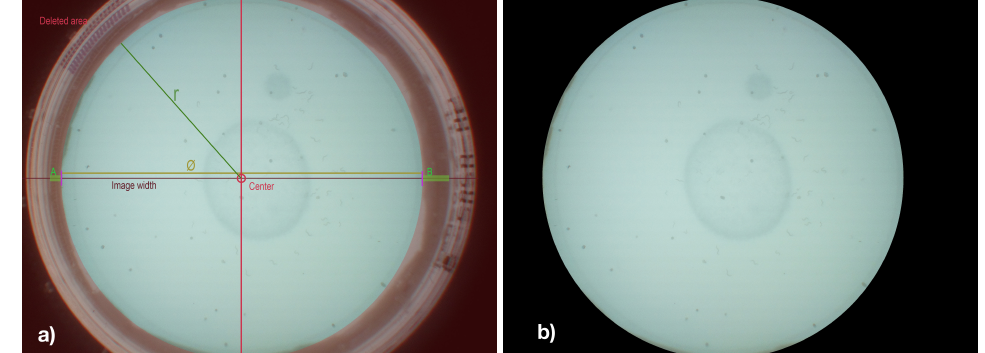
Figure 3. The surrounding pixel and the edge region of the Petri dish are removed from consider- ation (by blackening them out). Figure ( a ) Showing the original image and highlighting relevant information, ( b ) showing the resulting processed